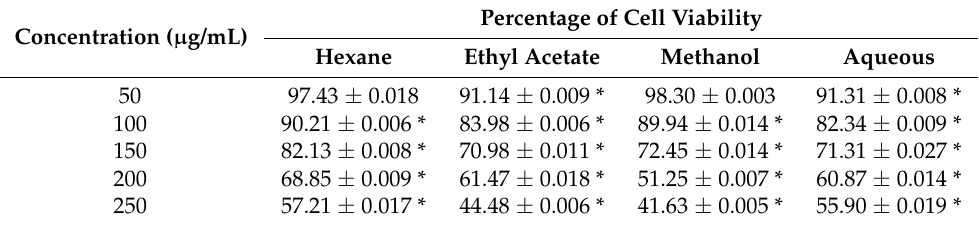
Table 3. Growth inhibitory activity of different solvent extracts of T. terrestris against Breast cancer MCF-7 cell